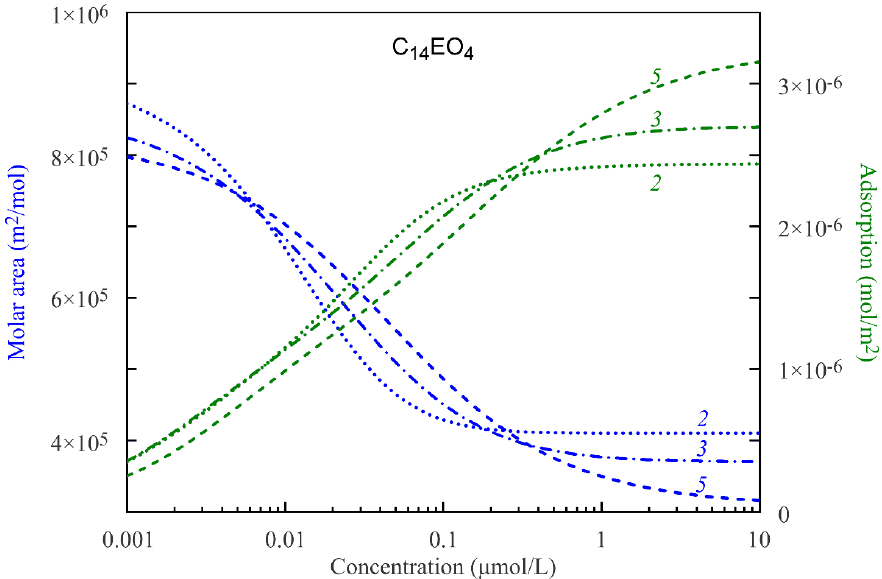
Figure 2. Average molar area (blue curves) and total adsorption (green curves) for C 14 EO 4 calculated assuming various numbers of segments: s = 2, 3, and 5, represented by dotted, dash ‐ dotted, and dashed curves, respectively, with the parameters listed in Table 1. For details see text.